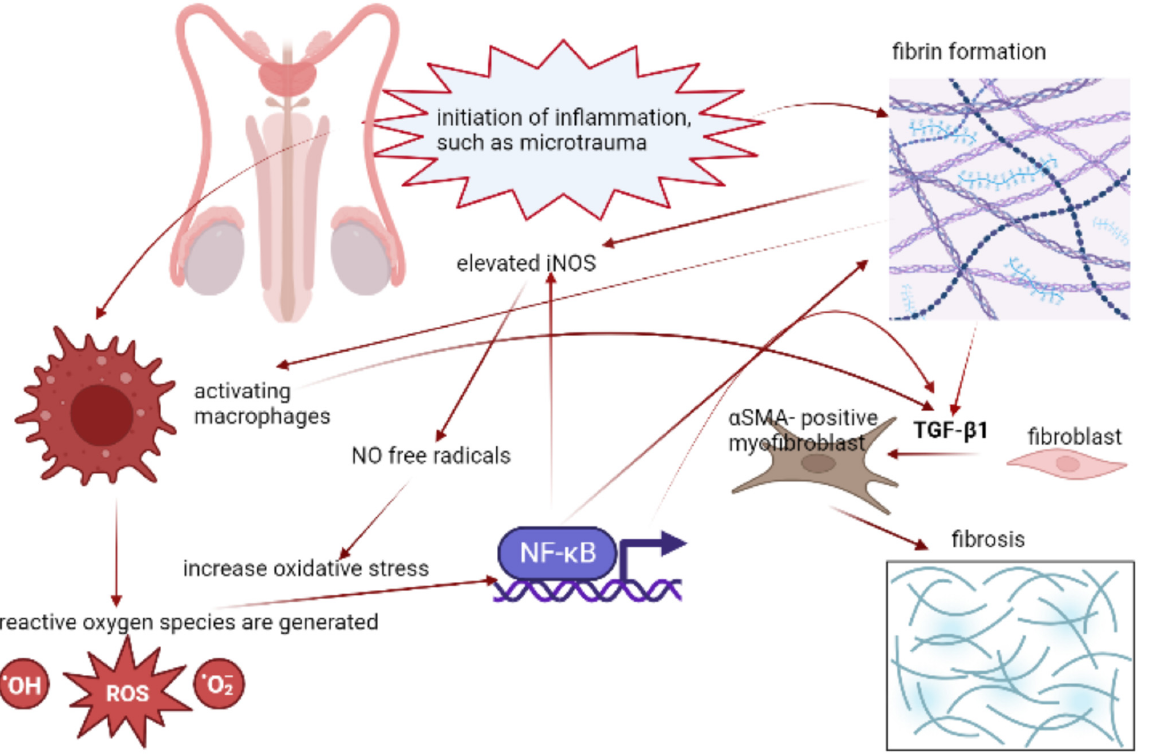
Figure 2. Inflammatory mechanism in PD. After the inflammation is activated, the activated macrophages and formation of fibrin will initiate the cascades up‑regulating the fibroblasts transformation, and subsequently lead to fibrosis.